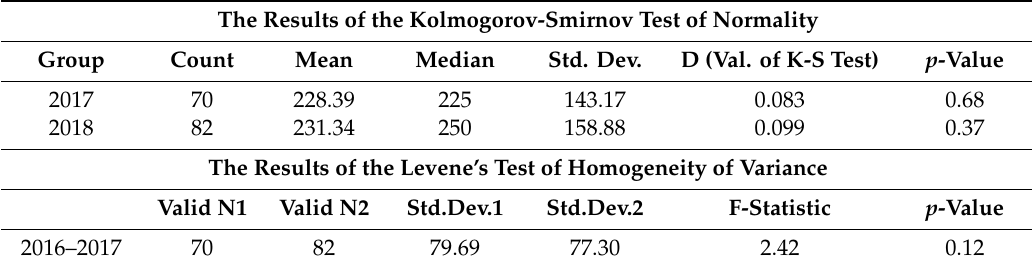
Table 7. Assumptions of normal distribution and homogeneity of